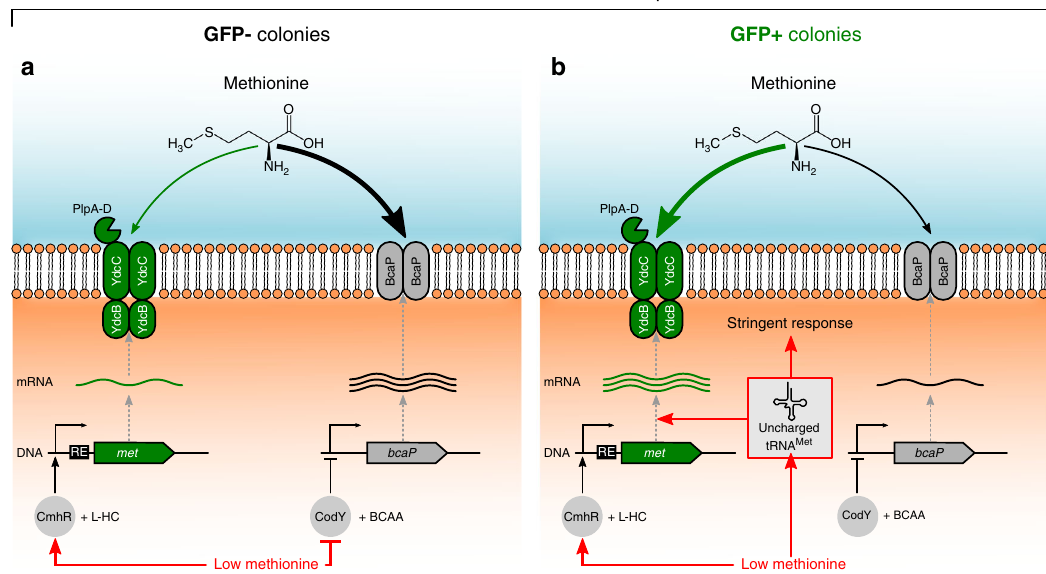
Fig. 7 Proposed model of methionine uptake and phenotypic heterogeneity in L. lactis . Free methionine can enter to the cell by two ways, via a low- af fi nity BcaP-transporter (branched-chain amino acid permease) and through a high-af fi nity Met-transporter (composed of the PlpABCD, YdcC and YdcB proteins). The met operon is regulated by CmhR, using homocysteine (L-HC) as coeffector. The expression of bcaP is controlled by CodY, which is activated by branched-chain amino acids (BCAA). At low methionine concentrations, the cells increase methionine uptake rates to sustain growth and two colony phenotypes are observed: GFP − colonies ( a ; left) and GFP + colonies ( b ; right). a In GFP − colonies the repression of bcaP by CodY is released timely, and the upregulation of the low-af fi nity transporter results in enough methionine to support growth. Although GFP − colonies weakly express the Met transporter as well. b In GFP + colonies, methionine starvation leads to the presence of uncharged tRNA Met , and this signal strongly up-regulates the expression of the met operon via the regulatory element (RE; T-box riboswitch) in the leader region of the met mRNA, which assures transcriptional continuation. In addition, the uncharged tRNA Met triggers the stringent response due to amino acid